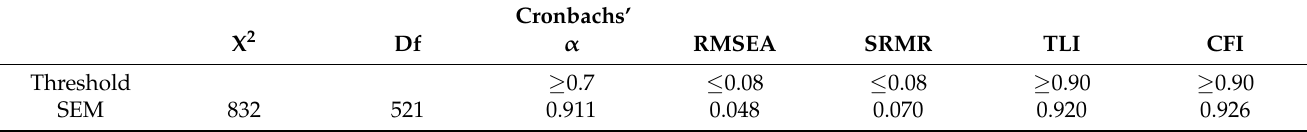
Table 5. Fit indices of the structural equation